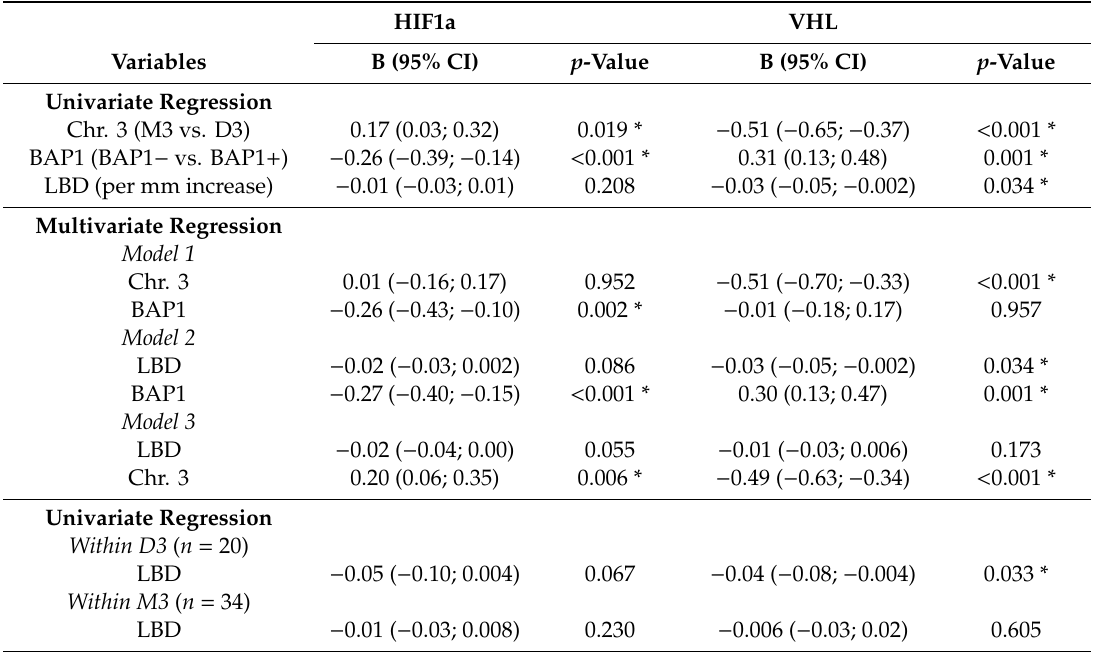
Table 4. Univariate and multivariate regression analysis on hypoxia-inducible factor 1-alpha (HIF1a) and von Hippel–Lindau (VHL) mRNA expression (based on the n = 54 lesions with data on HIF1a / VHL and chromosome status from the Leiden